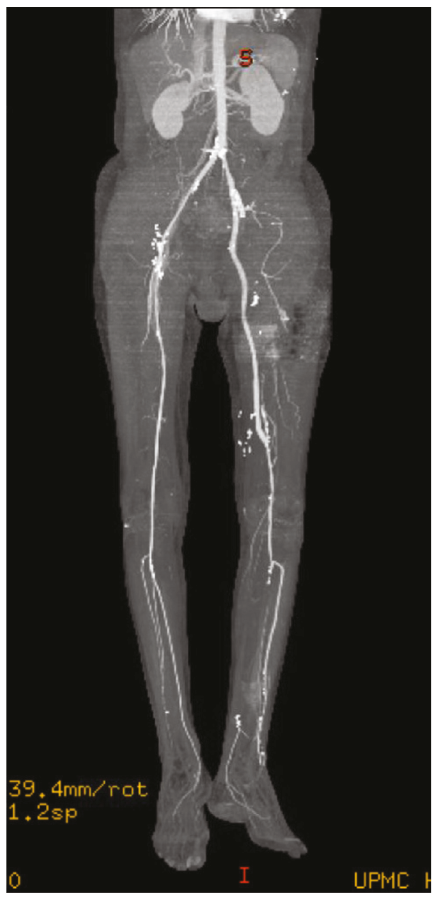
Figure 1: Previous right to left femorofemoral bypass with left external iliac stent occlusion.